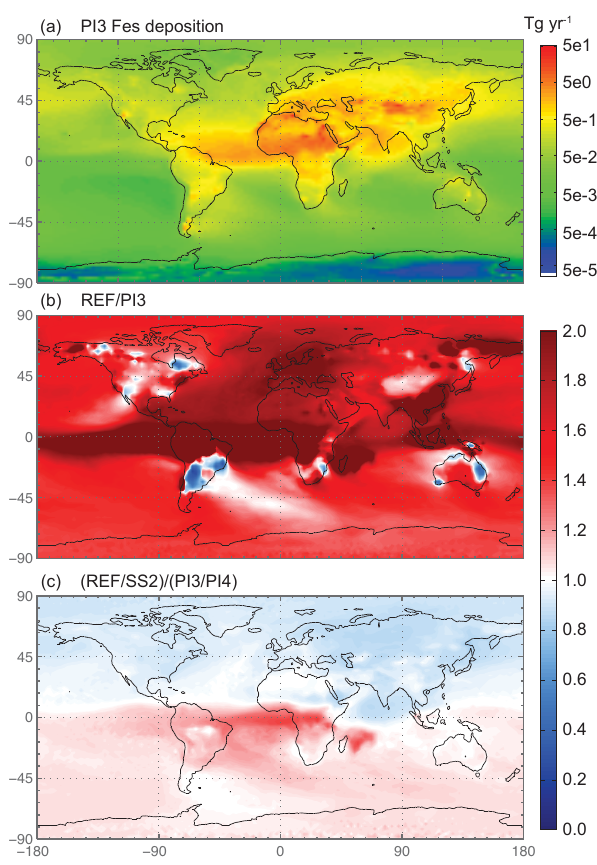
Figure 9. Spatial distribution of soluble iron deposition for the preindustrial simulation with the year 1850 chemical emissions, dust source strengths and combustion emissions (PI3) (Tgyr − 1 ) in panel (a) . Spatial distribution of the Fes deposition ratio of the ref- erence case over PI3 (b) , and the difference between the sulfate and OC proxies for current over preindustrial (c)